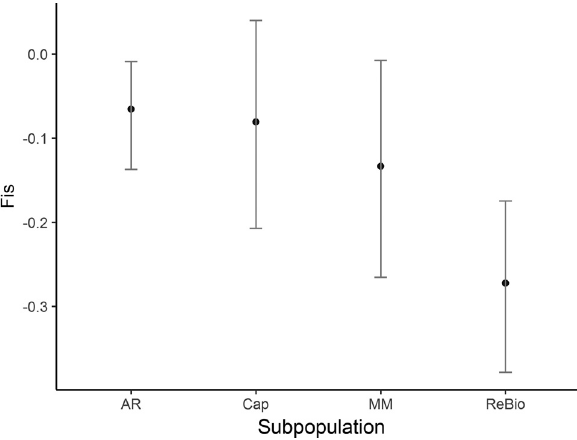
Figure 4 - Fixation index (Fis) estimated values with nSSR markers and 95% confidence intervals based on 10.000 bootstrap values for E. ovata subpopulations with nSSR